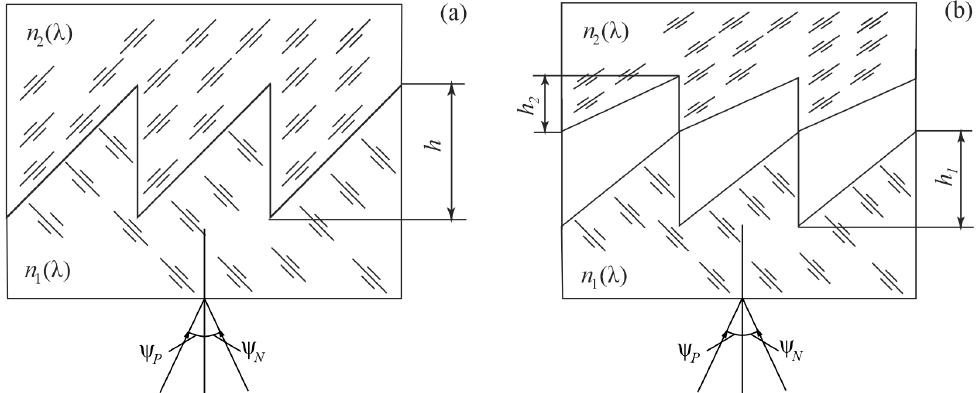
Figure 1. Two-layer single-relief ( a ) and double-relief ( b ) microstructures made of optical materials with refractive indices n 1 ( λ ) and n 2 ( λ ).